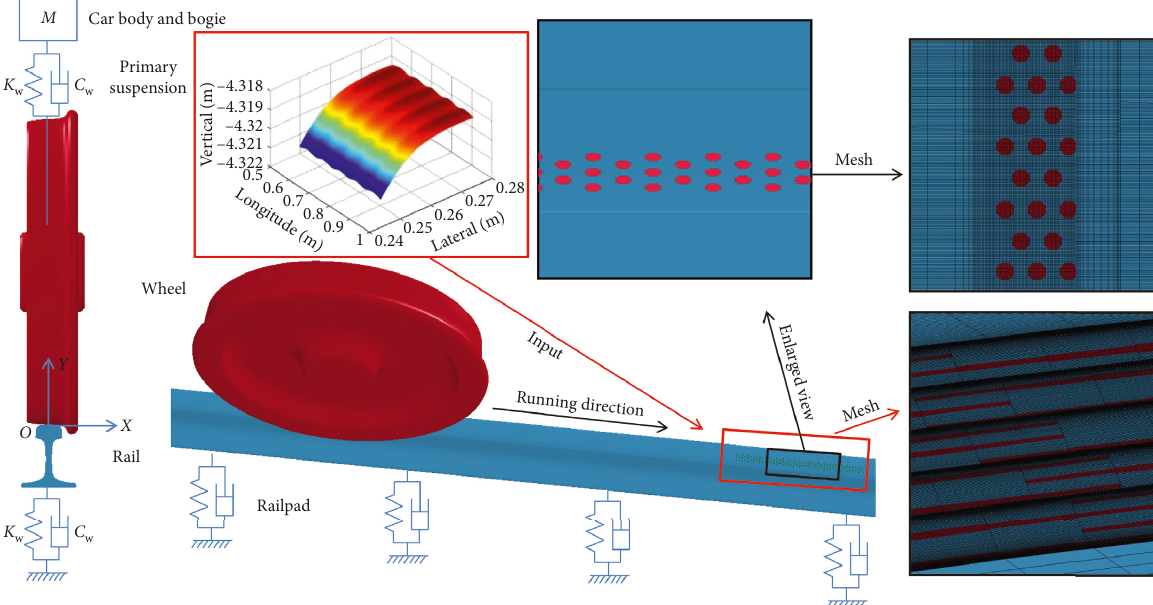
Figure 7: Schematic diagram of wheel-rail interaction with close-ups of mesh.